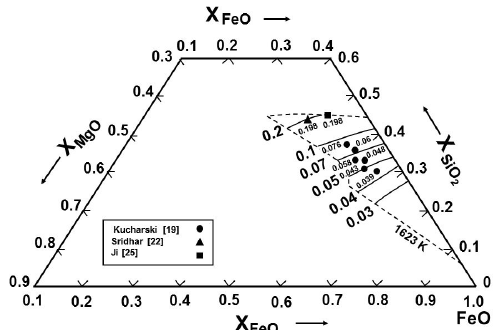
Figure 10. Isoviscosity curves (Pa ⋅ s) of SiO at 1723 K.